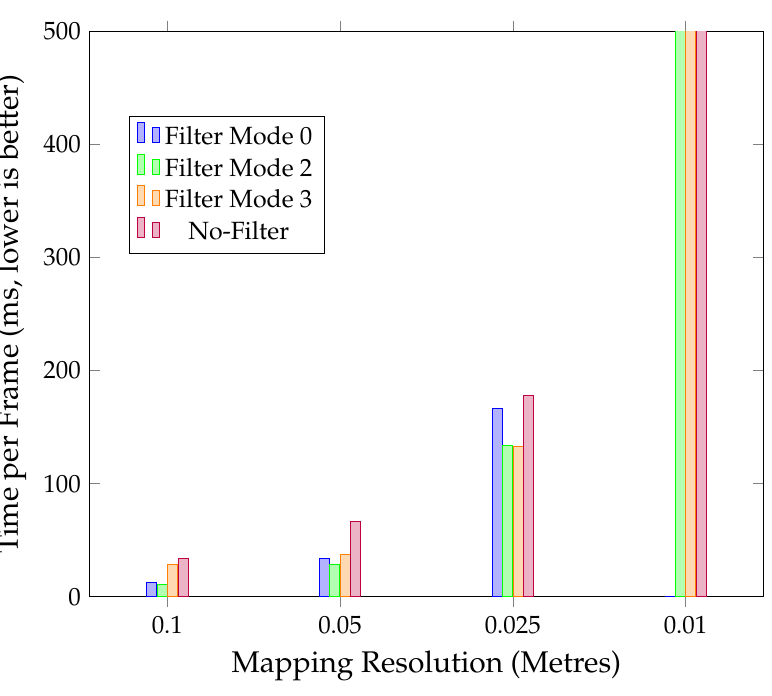
Figure 8. Nvidia Jetson-Nano NanoMap GPU performance. Table 4. Freiburg dataset average frame time for Asus G14 (ms, lower is better).